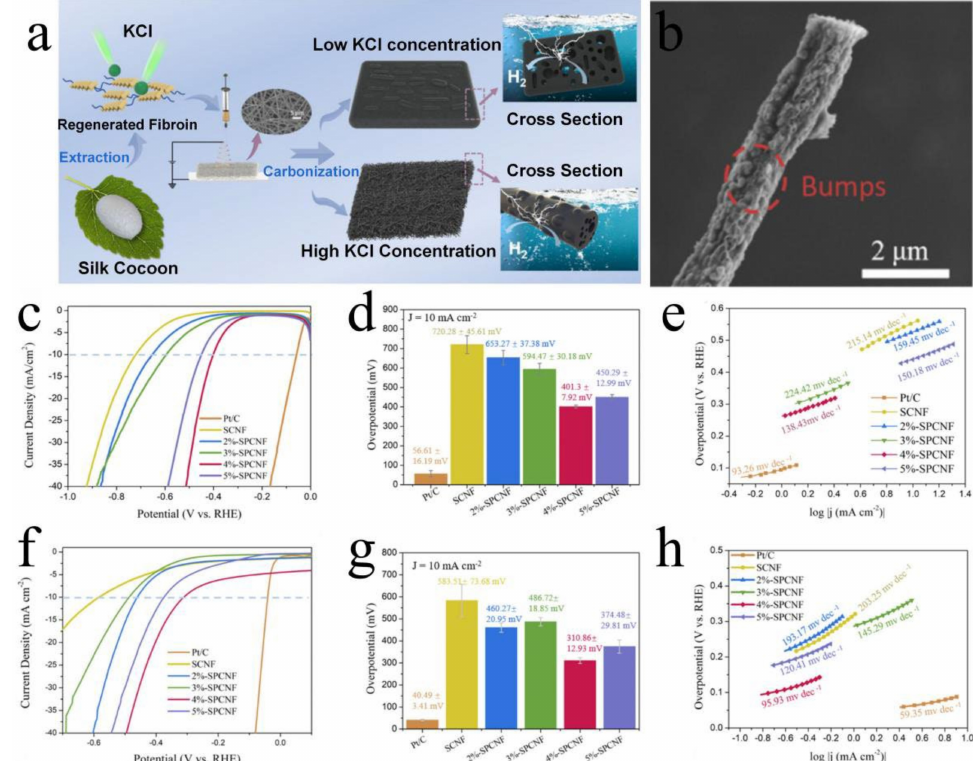
Figure 8. ( a ) Schematic diagram of porous CNFs prepared by electrospinning and HER. ( b ) SEM image of 4% − SPCNF single fiber. Acidic HER performance for ( c ) LSV curves of ( d ) bar chart of overpotential values, ( e ) Tafel slopes. Alkaline HER performance for ( f ) LSV curves of ( g ) bar chart of overpotential values, ( h ) Tafel slopes. Reprinted from Ref. [152] Copyright (2022) with permission from American Chemical Society.